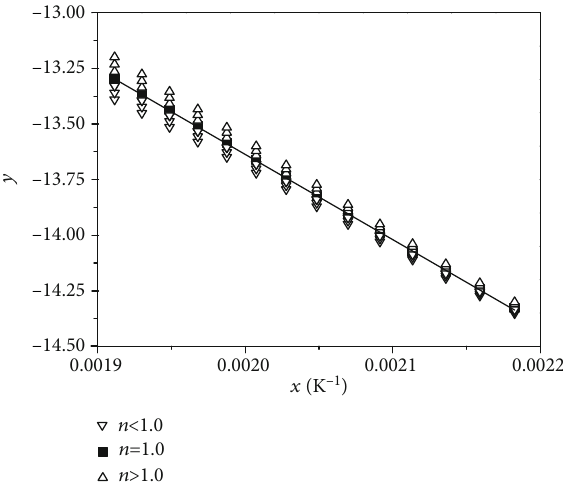
Figure 4: Coal tar combustion kinetic characteristics at 184-250 ° C.